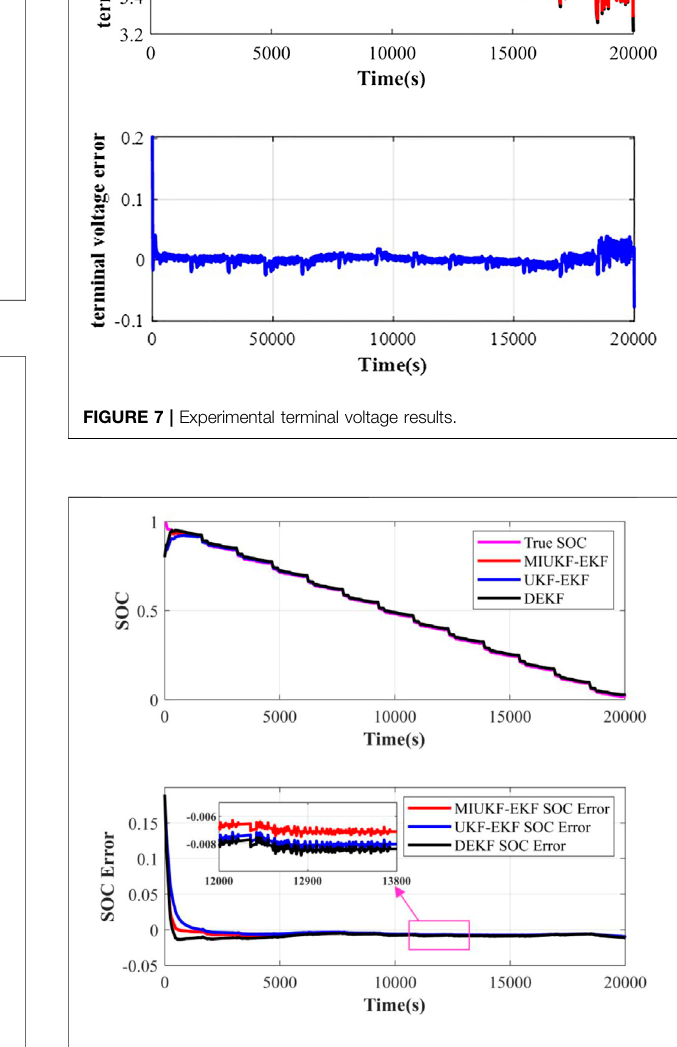
FIGURE 8 | SOC estimates and corresponding